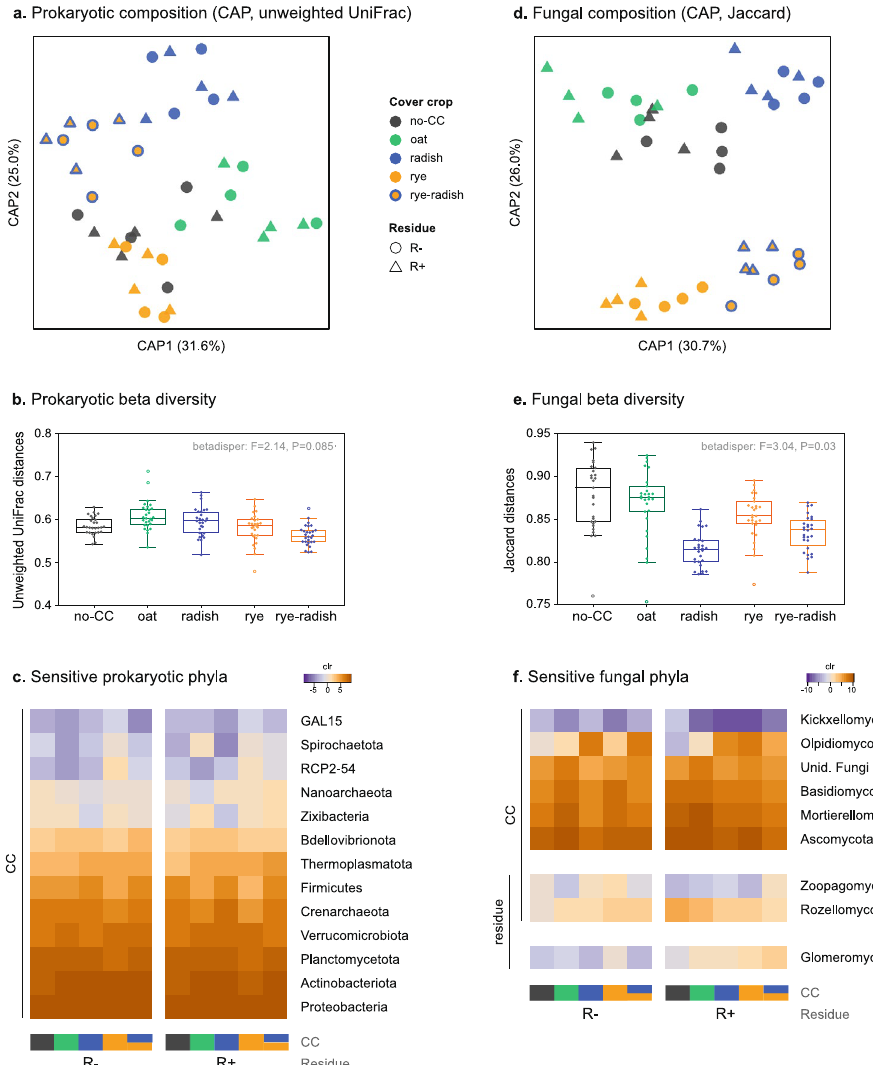
Figure 2. Microbial community structure in soils under different CCs and residue management: ( a , d ) Canonical analysis of principal coordinates (CAP) showing effect of CCs (and residue, for fungi); ( b , e ) Beta diversity as dispersion between different plots within each CC treatment, including betadisper results; ( c , f ) Heatmaps showing changes in the relative abundance of microbial phyla. In heatmaps, color gradient represents average relative abundance expressed as centered log-ratio (clr), and CC treatments are indicated by colored bars. R−/R+ refers to main crop residues absent or present, respectively. Heatmaps were created with R package ‘gplots’